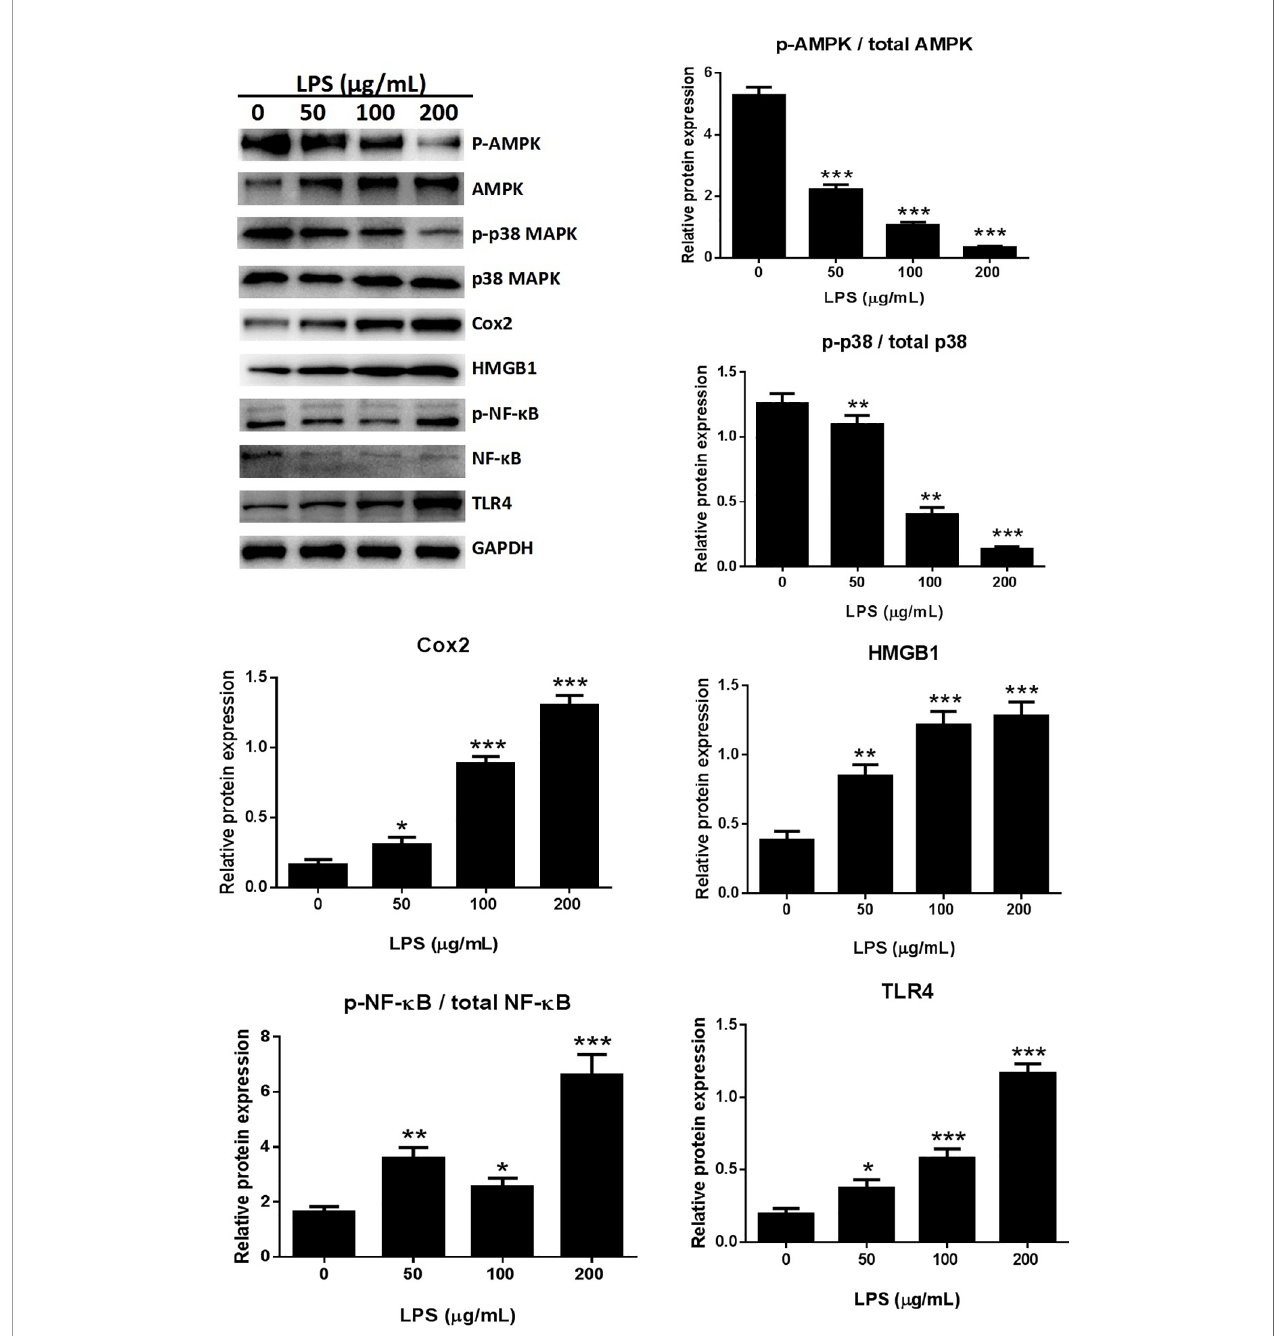
FIGURE 4 | LPS induced the release of in fl ammatory cytokines through the MAPK/NF- k B/TLR4 pathway. Western blot analysis and quanti fi cation of MAPK/NF- k B/ TLR4 signaling-related proteins in A549 cells stimulated with various concentrations of LPS for 24 h. *p < 0.05, **p < 0.01, and ***p < 0.001 compared with the control group. Graphs show the mean ± SD of triplicate wells and represent three independent